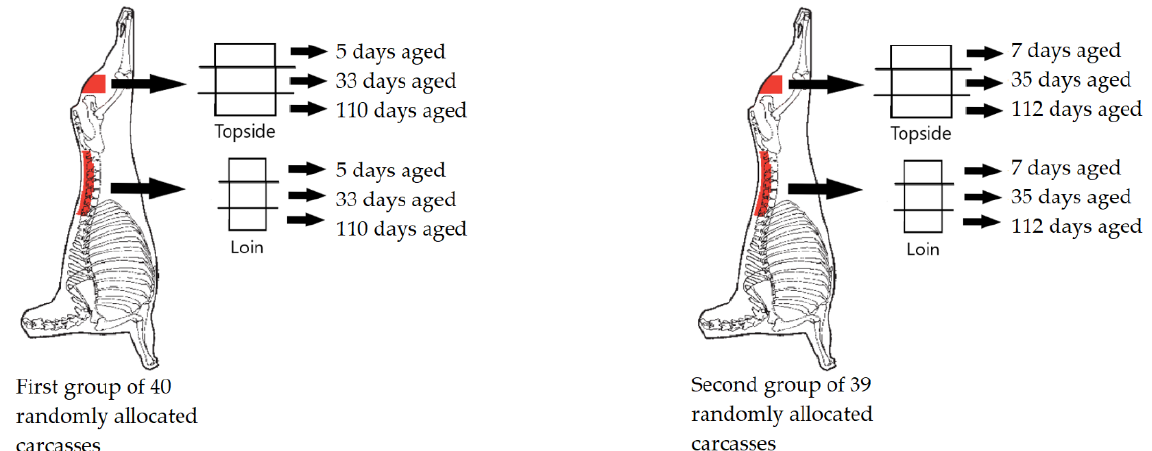
Figure 1. An example of loin and topside sample allocation to different storage periods for the two different groups of carcasses.